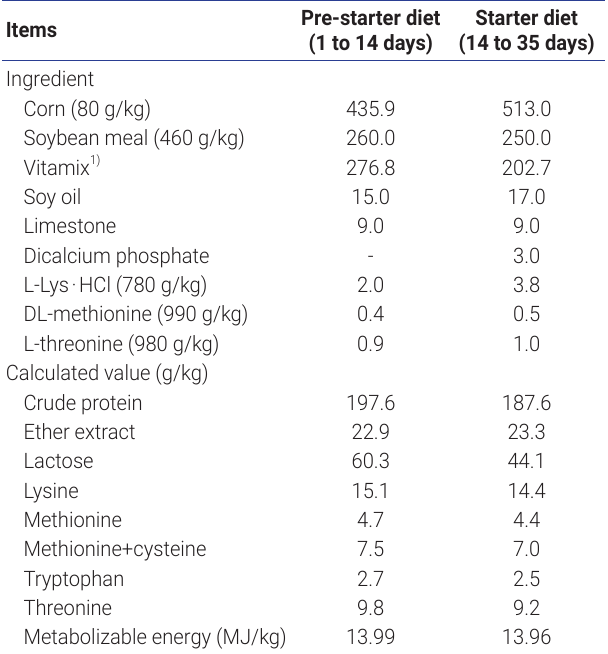
Table 1. Composition and calculated values of the basal diets (as- fed basis)